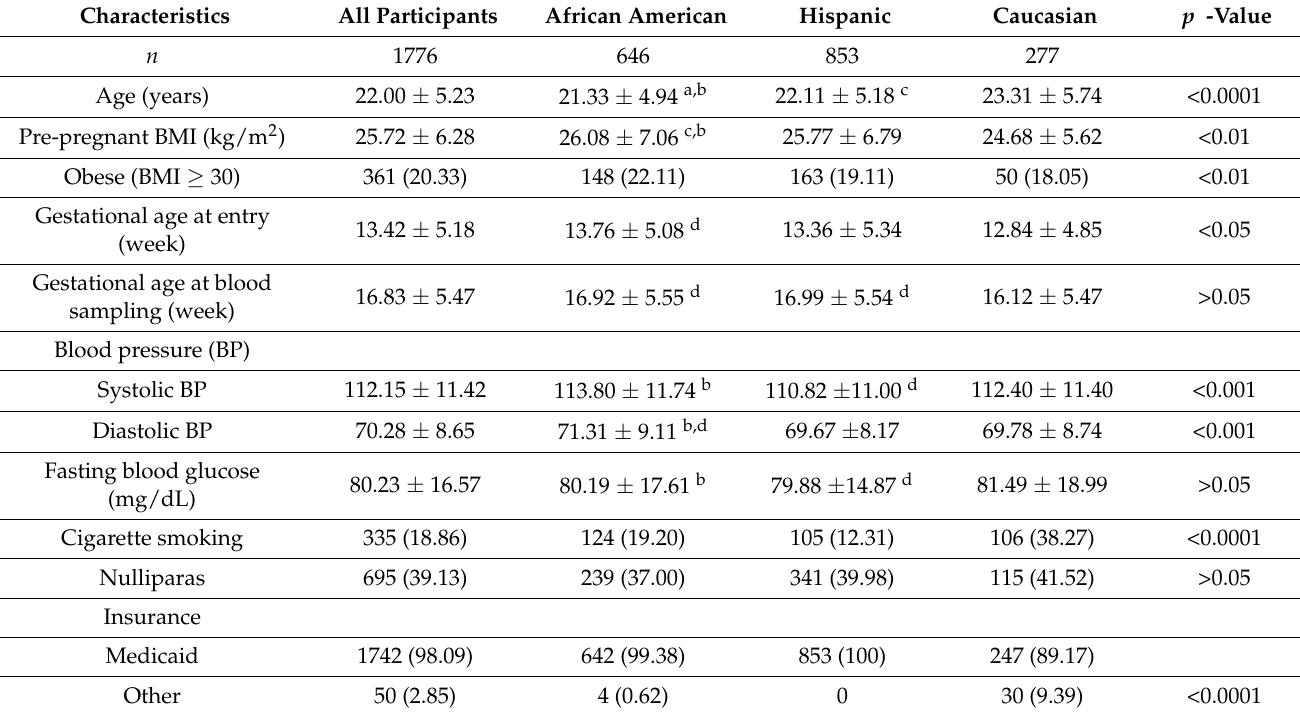
Table 1. Characteristics of study participants according to ethnicity at entry to care.